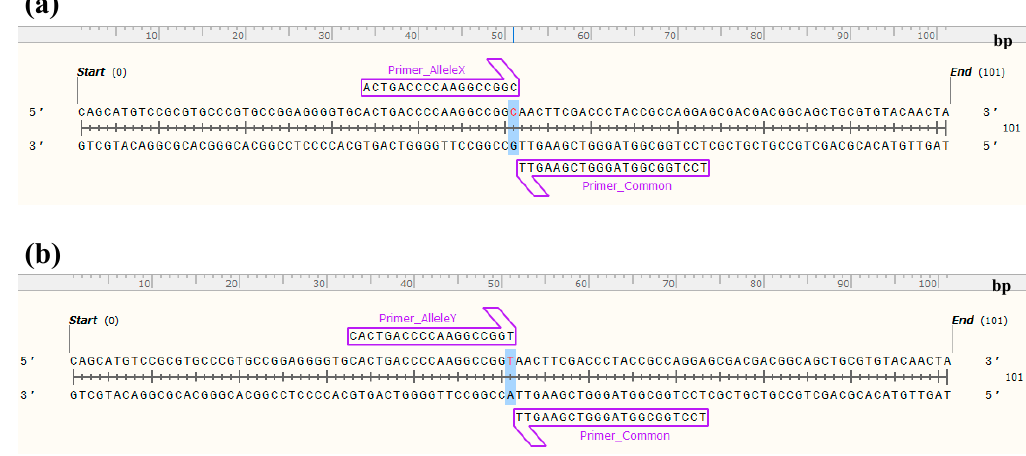
Figure 4. Allele specific forward and common reverse primers designed for Kompetitive Allele Specific PCR (KASP) assay marker MKAM_04_031. ( a ) allele X (LM11), ( b ) allele Y (CML25).